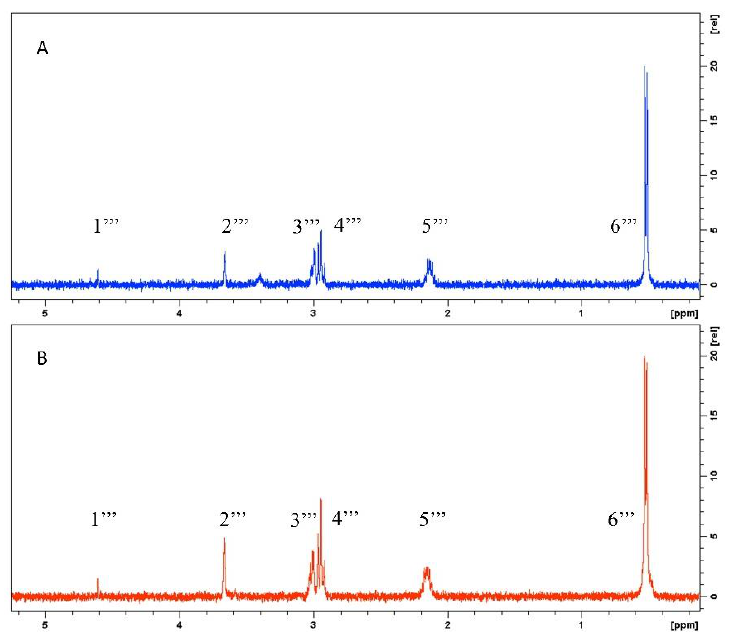
Figure 4. Selective 1D-TOCSY (400 MHz, DMSO- d 6 ) of hepatodamianol:CH 3 -6 (cid:48)(cid:48)(cid:48) . ( A ) 5 mM hepato- damianol standard solution. ( B ) T. diffusa standardized extract. The selective 1D-TOCSY spectrum allows us to assess the hepatodamianol content in T. diffusa standardized extracts and shows the selectivity of hepatodamianol:CH 3 -6 (cid:48)(cid:48)(cid:48) resonance in qNMR experiments.